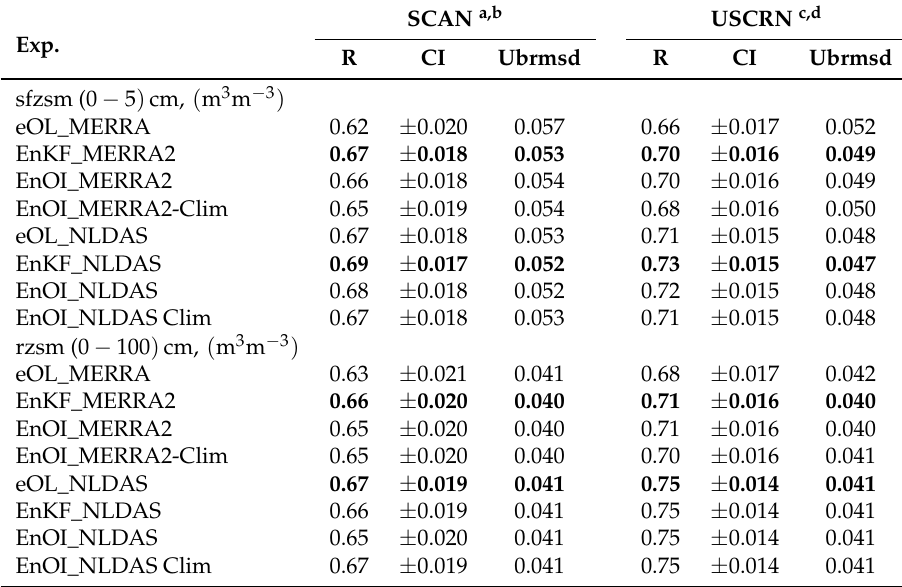
Table 3. Surface and root-zone Pearson R correlation coefficient and unbiased root mean square difference (ubrmsd) with SCAN and USCRN in situ networks. Confidence intervals (CI) are given in half values of the 95% interval for the individual experiments. The experiments with highest skill metrics are highlighted in